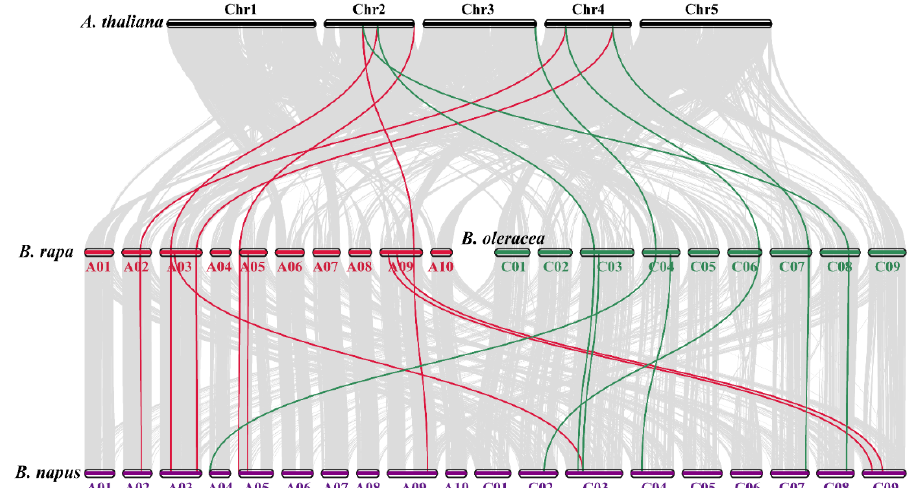
Figure 3. Synteny analysis of GPX genes in Brassica napus , Brassica rapa , Brassica oleracea , and Arabidopsis thaliana chromosomes. Gray lines in the background indicate the collinear blocks within Brassica napus and other plant genomes, whilst the red and green lines emphasize the syntenic GPX gene pairs. Genes located on the Brassica napus A and C sub-genomes are syntenic with Brassica rapa , Brassica oleracea , and Arabidopsis thaliana